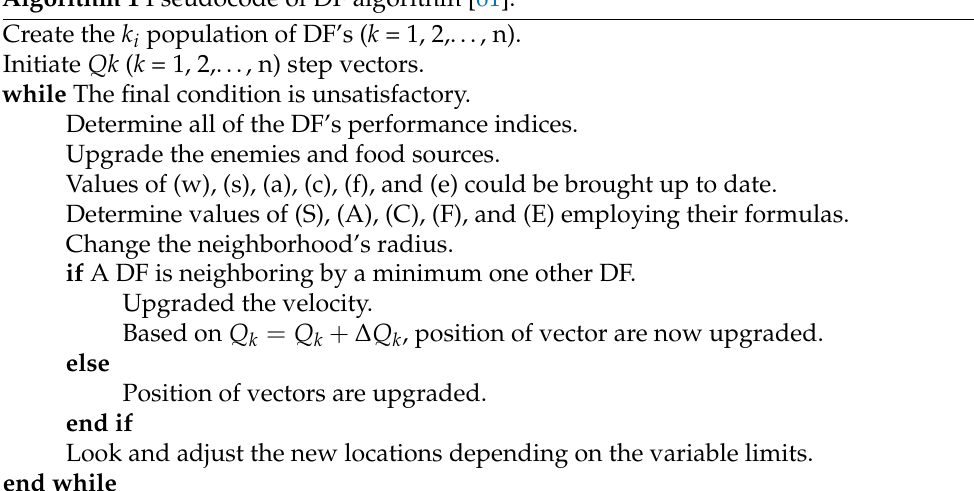
Algorithm 1 Pseudocode of DF algorithm